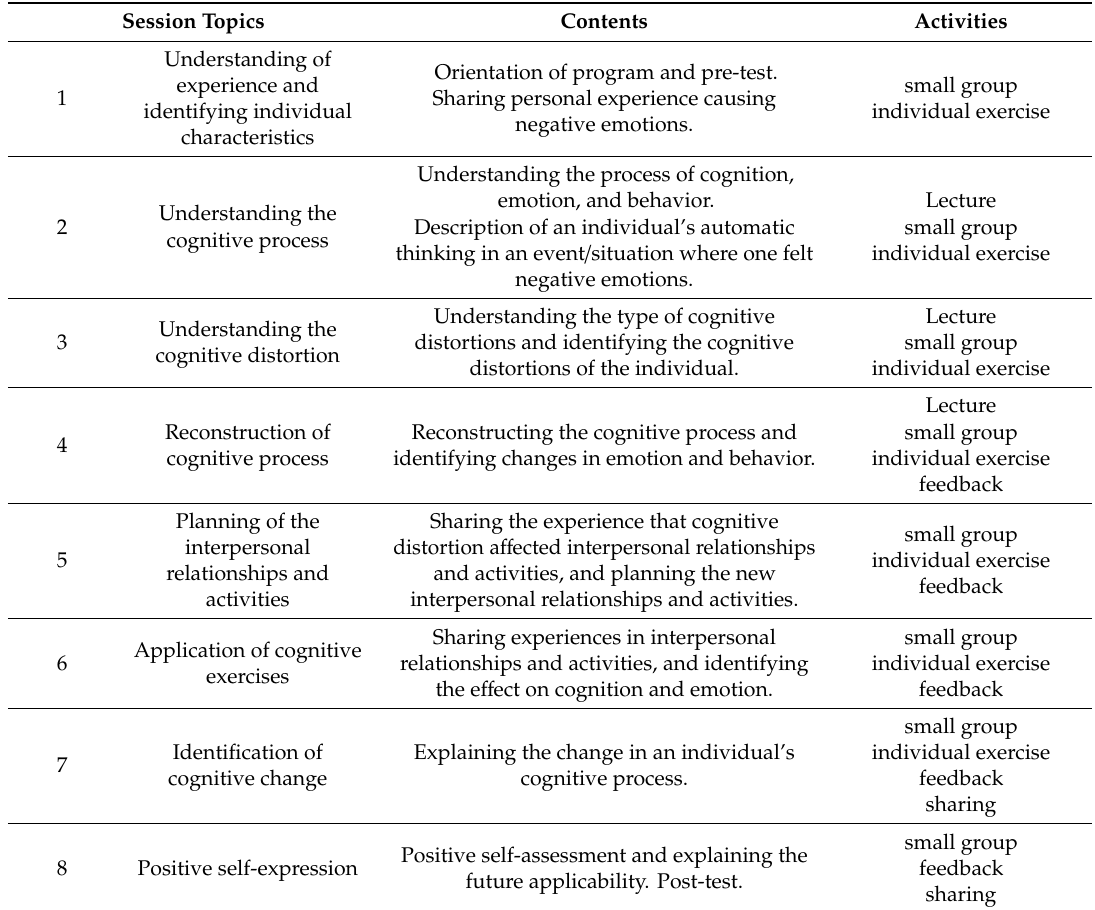
Table 1. The Contents of Group Cognitive Behavioral